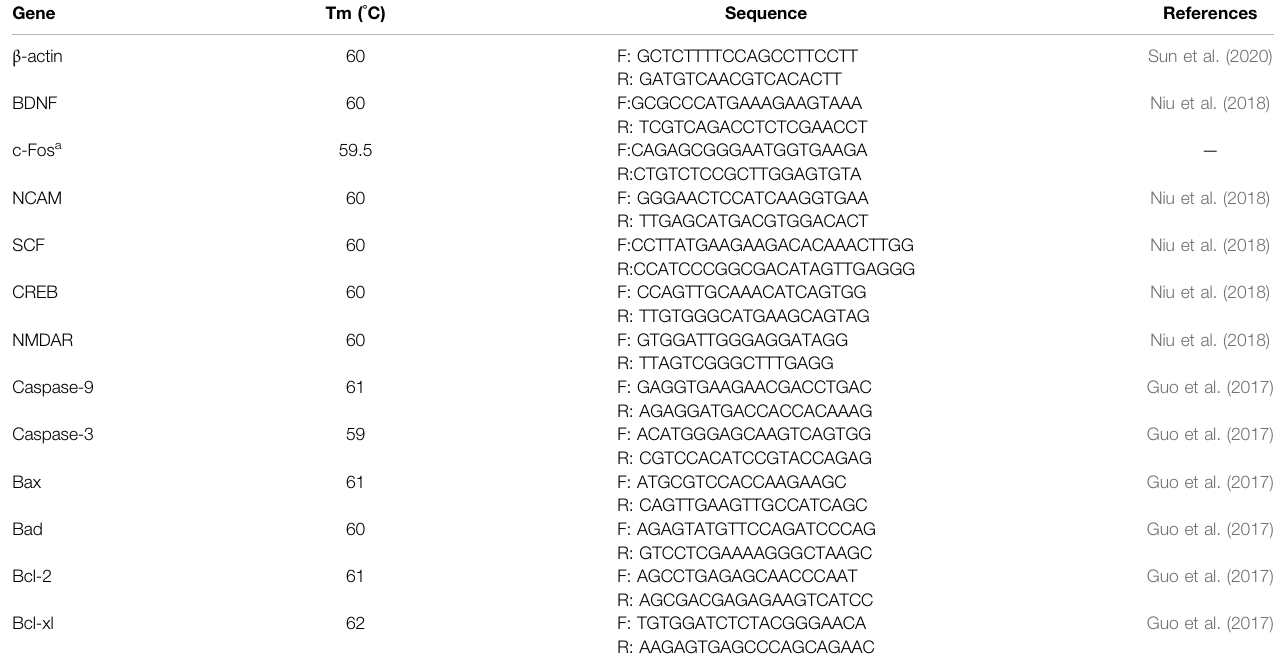
TABLE 1 | Primer sequences for RT-qPCR in hippocampus.